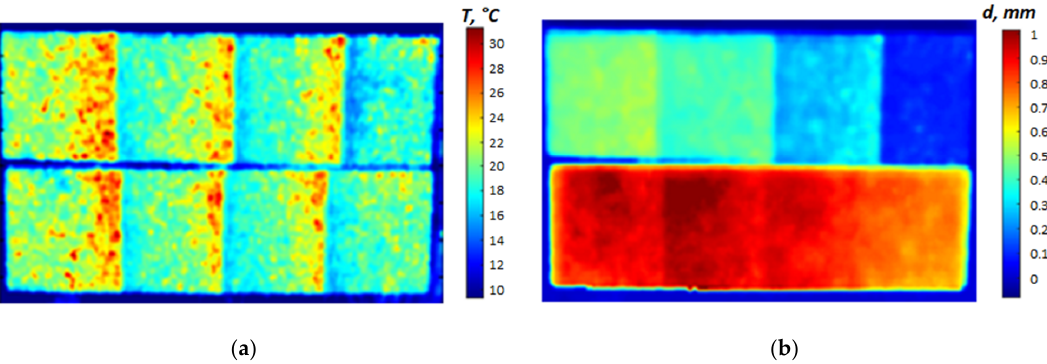
Figure 9. Raw IR thermogram at 10 ms after the flash ( a ) and map of coating thickness ( b ).